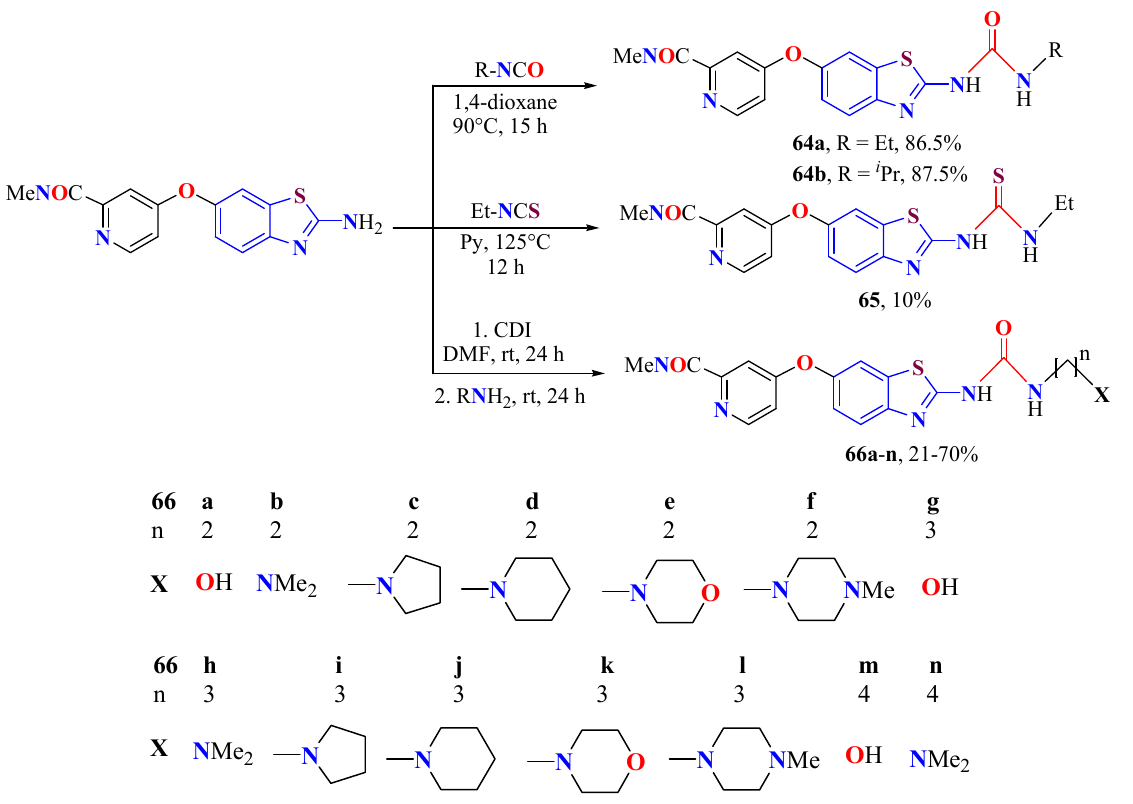
Scheme 21. Three ways to synthesize picolinamide based UBTs 64a , 64b , ethyl TBT 65 , and UBTs 66a – n